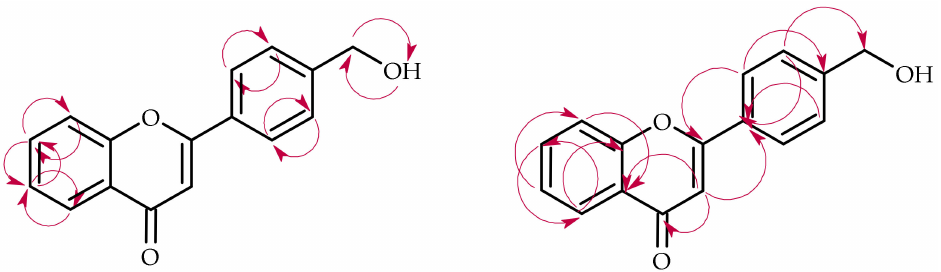
Scheme 8. Key COSY (on the left ) and HMBC (on the right ) correlations for the structure elucidation of product 5a